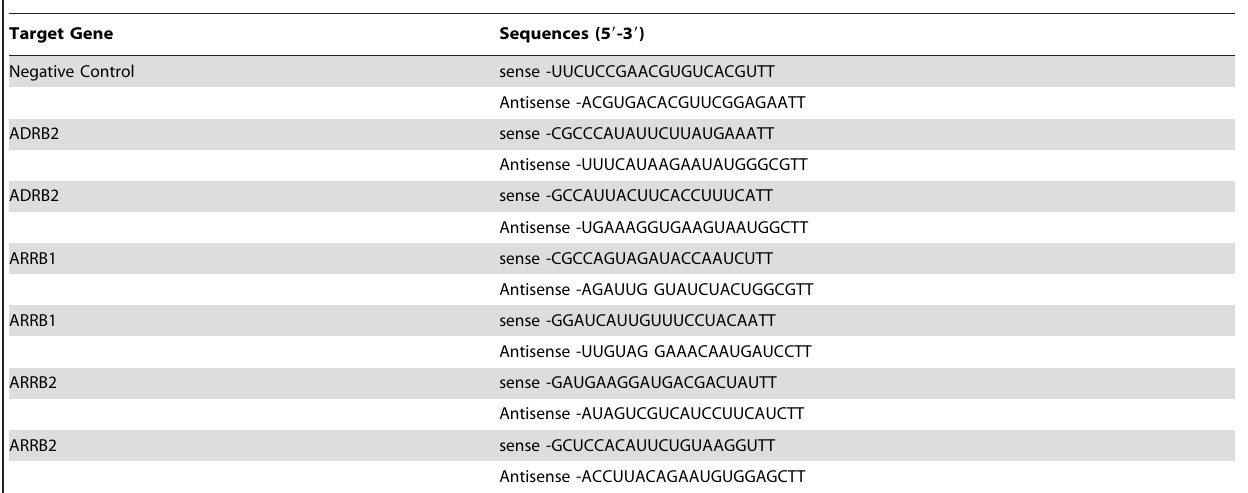
Table 1. Si-RNA sequences used in the experiments.